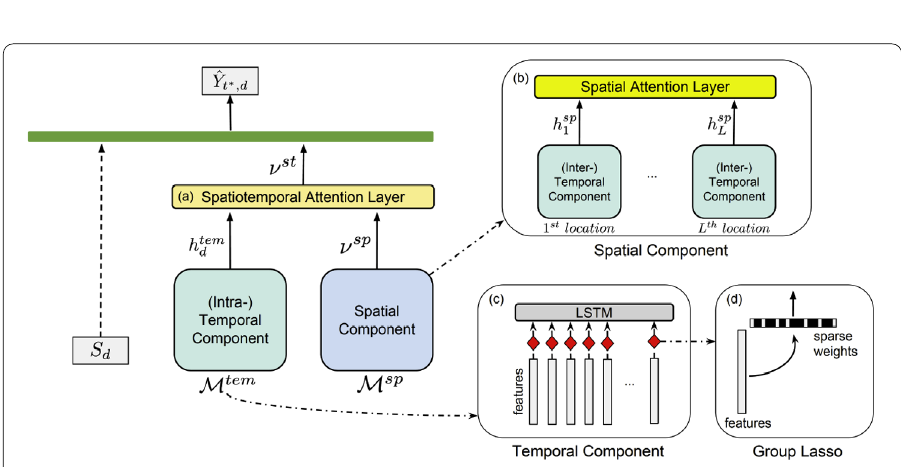
Figure 1 Spatiotemporal occurrence for different social movements by date ( x -labels) and by location ( y -labels). A red circle indicates at least one offline protest event happening on a particular day and state; the blue shade indicates the volume of tweets posted on the corresponding day/state. Charlottesville counterprotests exhibited burst patterns, in which most of the activities were sparked by a deadly violence attack and President Trump’s statements on Aug 12th, 2017. In the first few days following the attack and the statements, more protest events occurred nation-wide and larger tweet volume was observed. The Ferguson I protests appeared to have a gradual build-up process, in which the activities were initially local (around Missouri and few states) following the shooting of Michael Brown on Aug 9th, 2014 and later received global attention. A global increase in tweet volume was observed until Aug 20th, 2014. The Ferguson II protests started on Nov 24th, 2014, with the announcement of the jury decision not to indict the police officer, and garnered global attention. The tweet volume for each state was greater in the first two days after the jury decision compared to the other days